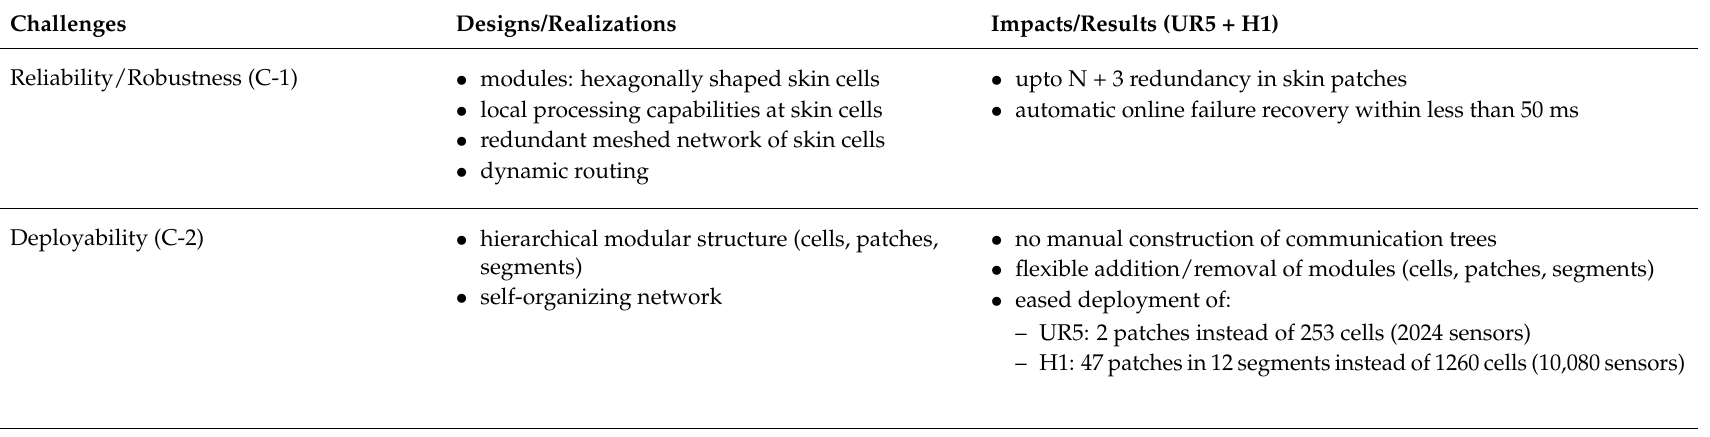
Table 3. Challenges, designs, and their impacts on scalable large-area skin systems